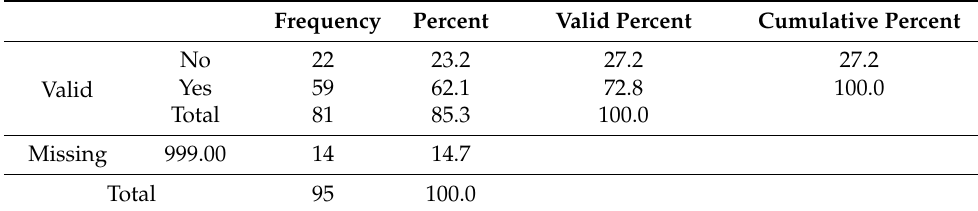
Table 5. Maximum Visual IVs (between-subjects